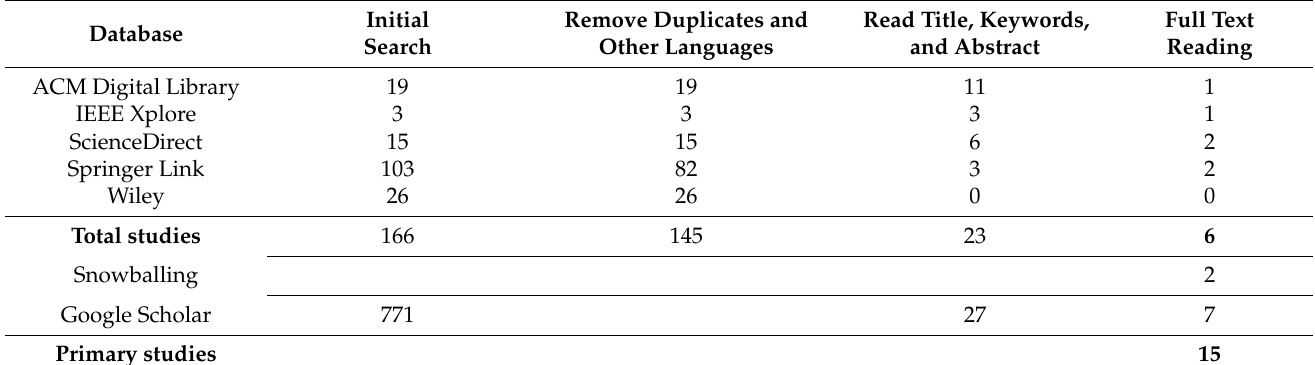
Table 1. The results from each